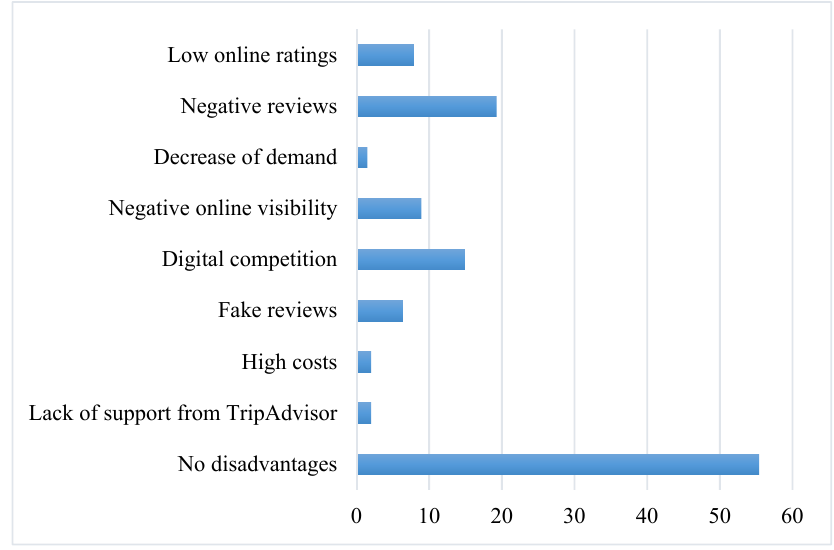
Figure 8. TripAdvisor’s contribution toward firm success (%).